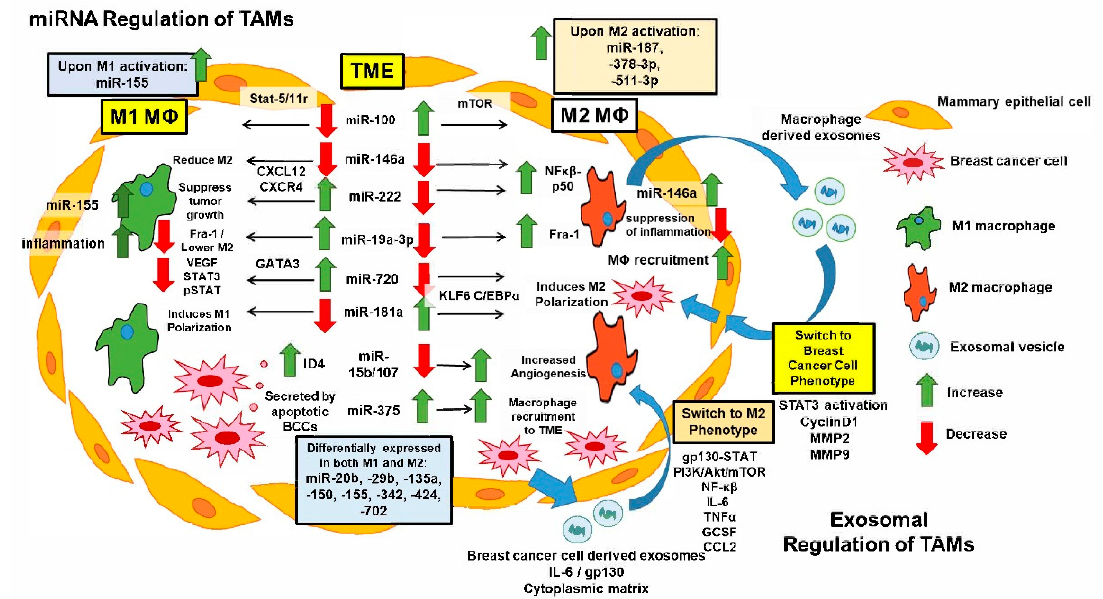
Figure 4. miRNA and Exosomal Effects in Breast Cancer. miRNAs manipulate tumor activity inside breast cancer cells through various downstream effects (shown on left). Inflammatory M1 and TAM M2 macrophages (MØ) within the TME show differential effects based on miRNA expression patterns and changes within each MØ phenotype (left-center, black boxes). Green and red arrows indicate up- or down-regulation of various effects, while black arrows indicate pathways. Exosomal production by the BCCs and M2 MØs within the TME has various effects, including M2 polarization, cell invasion, metastatic progression, and protumoral TME progression (right side, blue arrows). Depending on what miRNAs and exosomal effects are present, it would potentially be possible to switch the TAMs phenotype and thus the TME into a more beneficial state for the host.